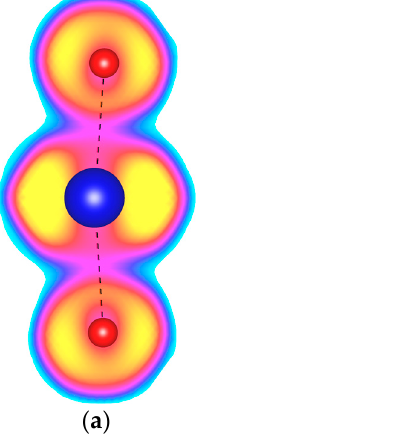
Figure 2. The Electron Localization Function (ELF) plotted for ( a ) the KrF 2 molecules found in the Cmcm phase of KrF 2 at 150 GPa; ( b ) the KrF 4 molecules found in the I4/m phase of KrF 4 at 150 GPa. Yellow color depicts ELF values above 0.9, cyan—below 0.1, while magenta corresponds to values of 0.4. Kr–F covalent bonds are depicted with a black dashed line.